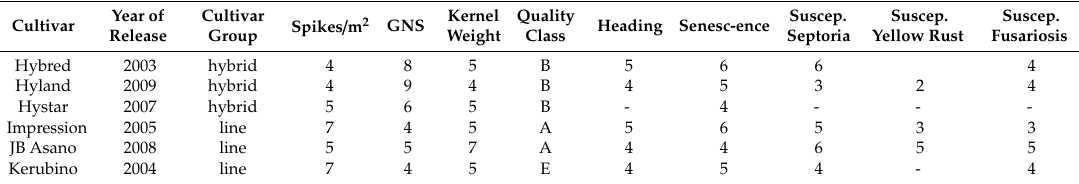
Heading Senesc-ence